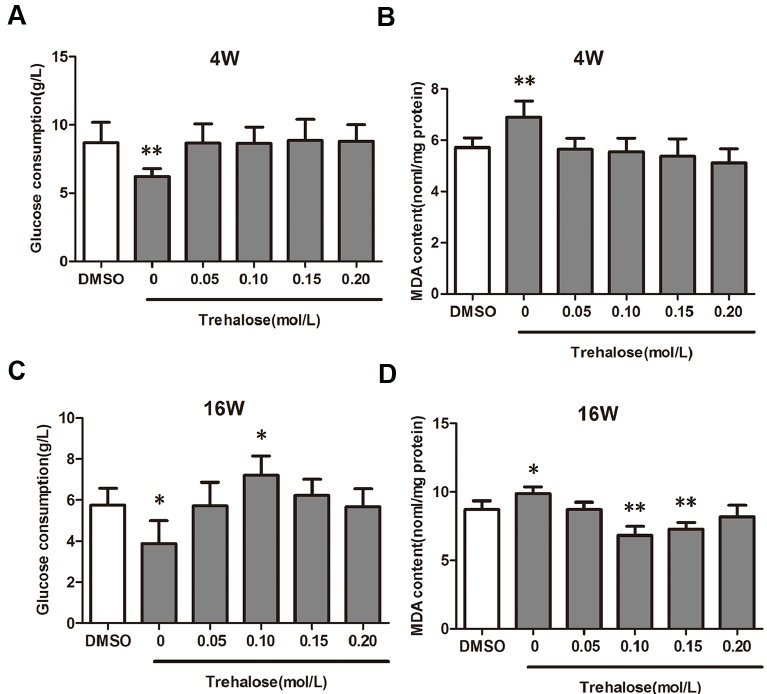
Fig 1. Trehalose improved cell glucose consumption and decreased MDA content of cryopreserved valve cells. Valve cells were treated with DMSO or trehalose (0–0.20 mol/L). (A) Glucose consumption, valves were cryopreserved for 4 weeks. (B) MDA, valves were cryopreserved for 4 weeks. (C) Glucose consumption, valves were cryopreserved for 16 weeks. (D) MDA, valves were cryopreserved for 16 weeks. Data are expressed as the mean ± SD ( n = 4 per group). (cid:3) P < 0.05, (cid:3)(cid:3) P < 0.01 versus the DMSO